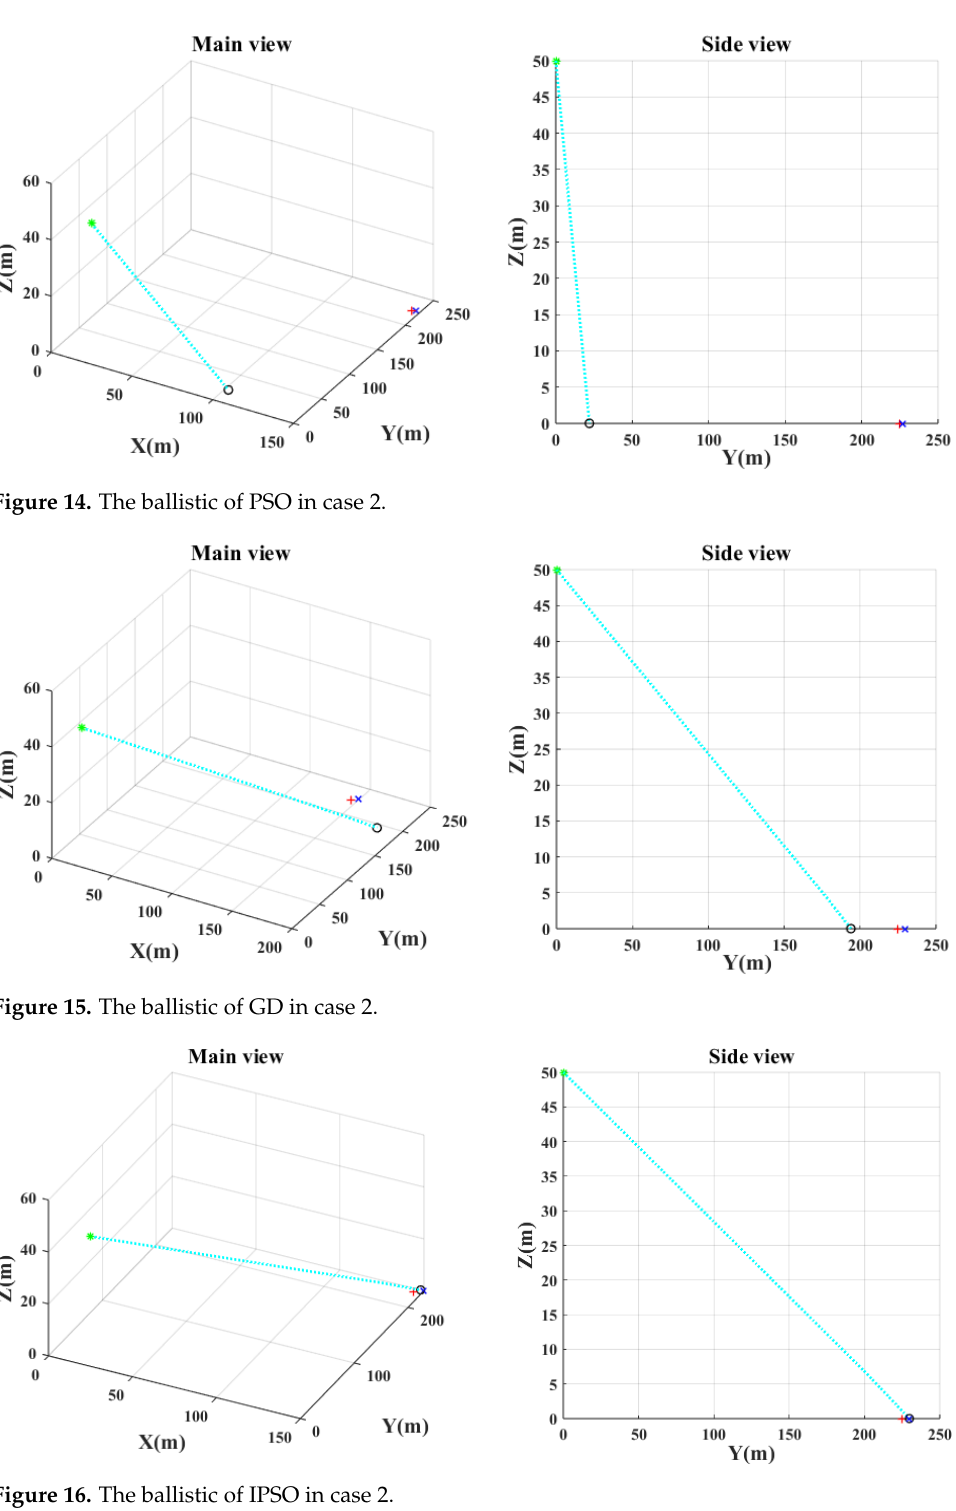
Figure 16. The ballistic of IPSO in case